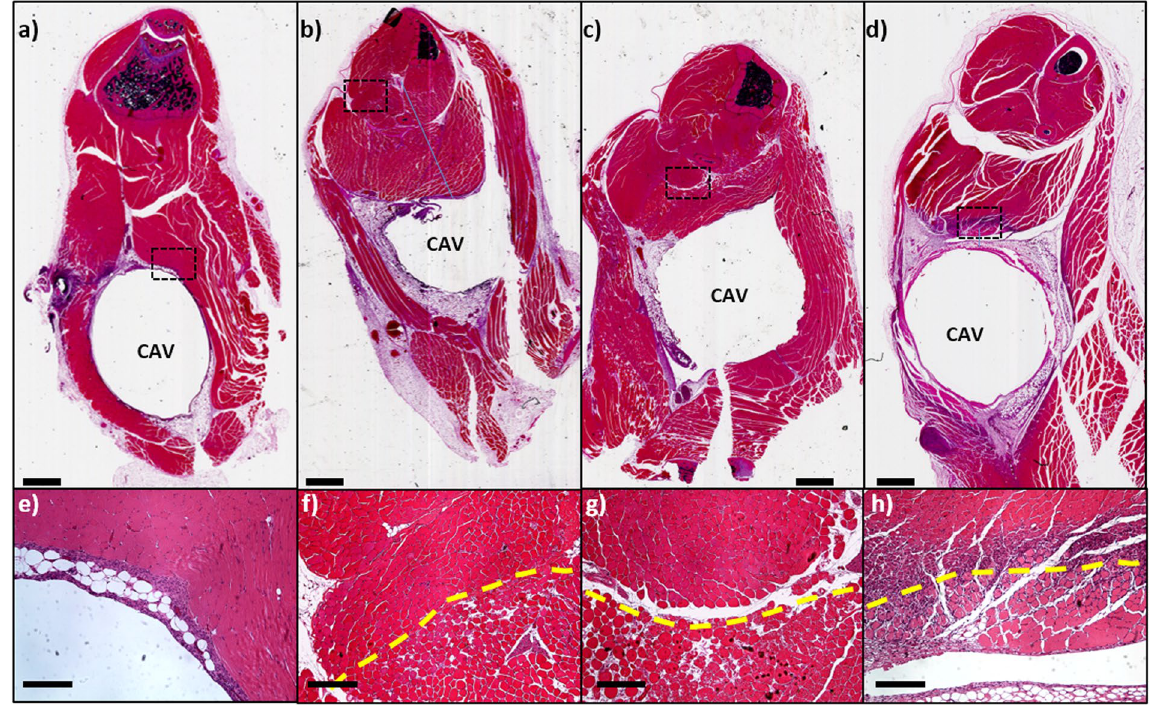
Figure 8. AMF exposures produce highly localized tissue damage in vivo . H&E stained sections through the thighs of mice receiving AMF exposures. The cavity (CAV) represents the location of a surgically implanted 5 mm stainless steel ball. The bottom panels are high power views of the ROI indicated in each of the top panels. A sham-treated mouse ( a , e ) 7 days after surgical implantation shows a residual mild inflammatory response at the edge of the cavity. A mouse receiving a 190 W AMF exposure for 220 s ( b , e ) exhibits a pattern of thermal damage all around the implant approximately 2 mm from the cavity. A similar pattern of damage is seen for a mouse exposed to 800 W for 15 seconds ( c , g ), however the radial extent is only approximately 1 mm. A mouse 7 days after an 800 W AMF exposure lasting 4 seconds ( d , h ) exhibits a circumferential pattern of damage extending to approximately 0.5 mm from the cavity rim. In addition, robust regenerative activity is seen at the edge of the thermal damage boundary. In all cases, the transition from damaged to normal muscle (dashed line in bottom panels) is abrupt. The top scale bars represent 1 mm and the bottom bars represent 200 µ